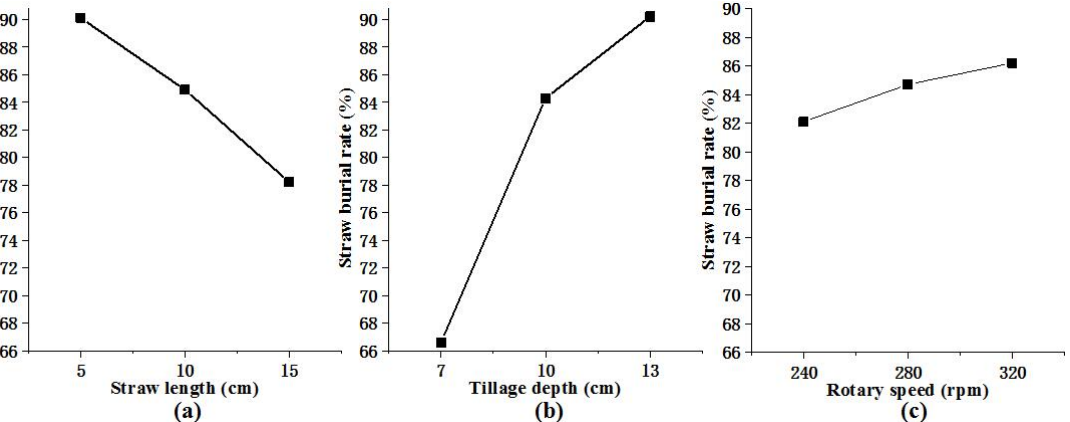
Figure 6. Effect of single factor on straw burial ( a ) relationship between straw length and straw burial, ( b ) relationship between tillage depth and straw burial, ( c ) relationship between rotary speed and straw burial.